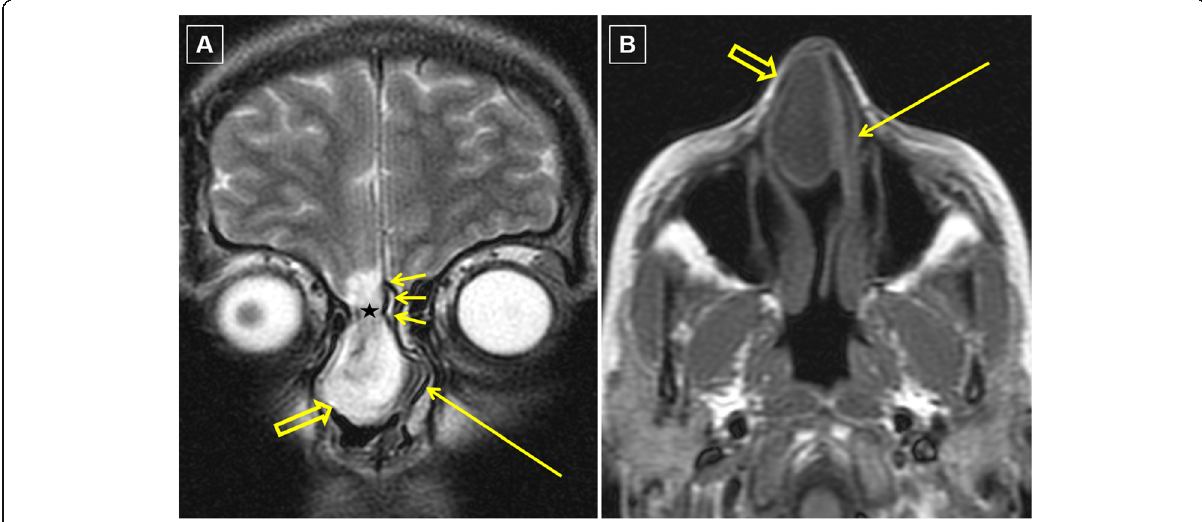
Fig. 5 Transethmoidal encephalocele. a (coronal T2 weighted) image shows herniation of intracranial content through the defect in the cribriform plate (star) seen lateral to the cribriform plate (short arrows). b (axial T1 weighted) image: Herniated content shown by an open arrow is displacing the nasal septum (long arrow) to the contralateral